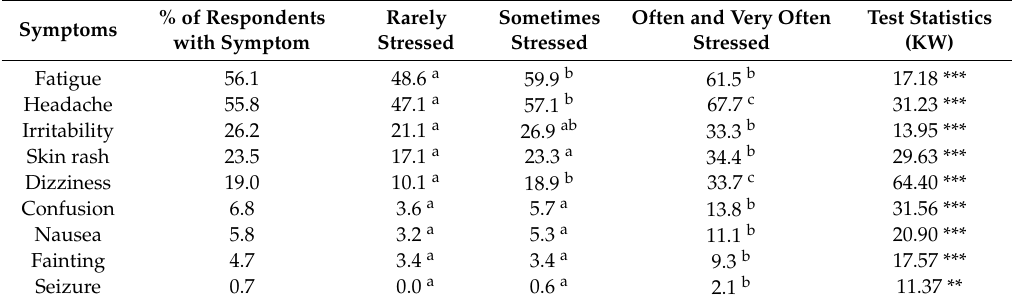
Table 3. Self-reported symptoms of heat stress in the workplace of those respondents reported heat stress (%)—by degree of heat stress (N =